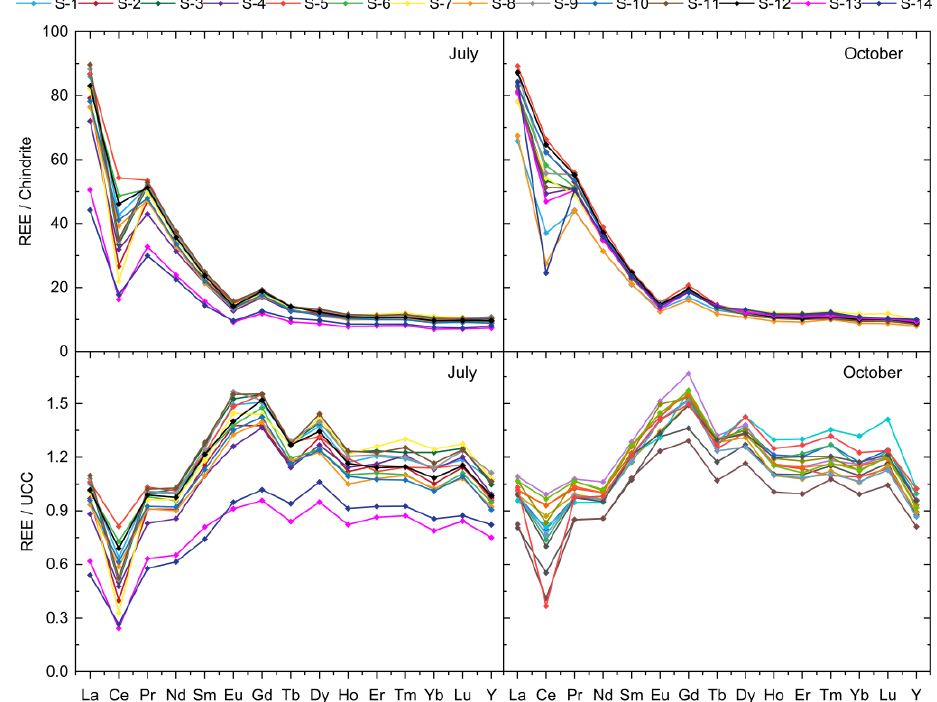
Figure 4. The Chondrite-( up ) and UCC-normalized ( down ) REE concentration distribution in the investigated samples for both sampling sessions.